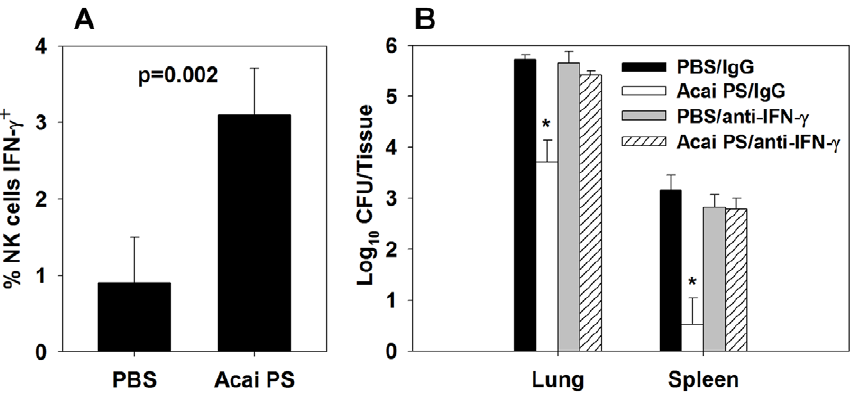
Figure 5. Acai PS enhances IFN- c by innate leukocytes during pulmonary type A F.tularensis infection. C57BL/6 mice (n=5/group) were treated i.n. with 1 mg of Acai PS one day prior to i.n. infection with 50 CFUs of F. tularensis SchuS4. Some mice were also depleted of IFN- c two days prior to infection. A) Intracellular expression of IFN- c was determined for lung NK cells by flow cytometry, and two days after infection, and B) lung and splenic bacterial burdens were determined. Data are representative of two independent experiments. Error bars depict SEM. *P , 0.05 as compared to PBS-treated animals receiving the same antibody treatment.